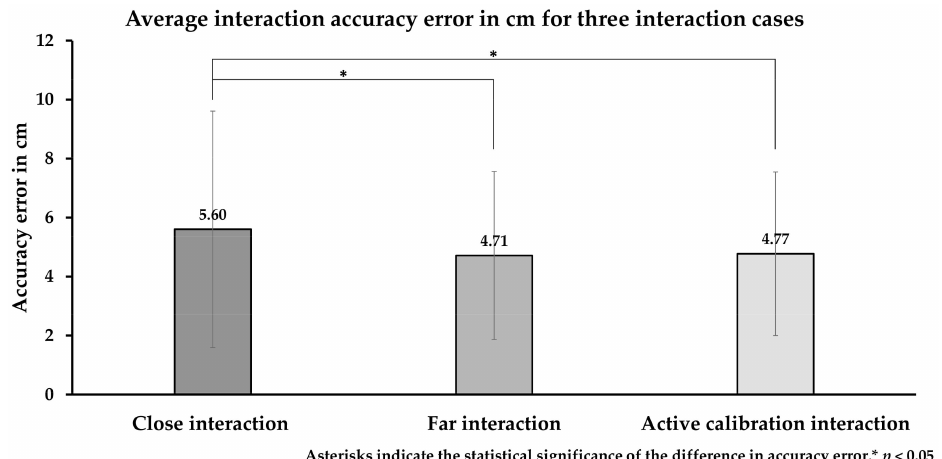
Figure 12. Accuracy error for close, far, and active calibration interaction cases.